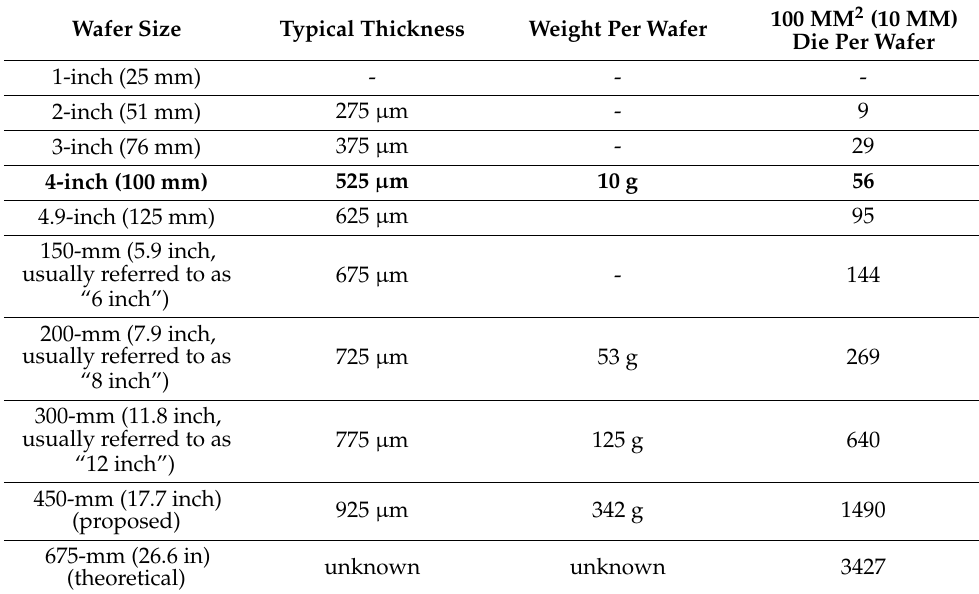
Table 1. Silicon wafers manufactured in different diameters and thicknesses. Wafer Size Typical Thickness Weight Per Wafer 100 MM